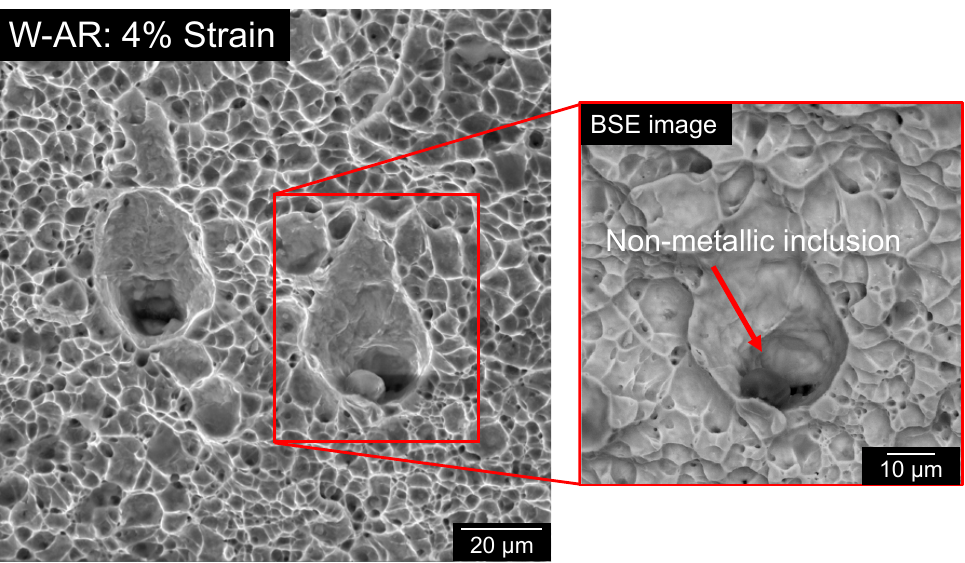
Figure 8. Non-metallic inclusion in W-AR sample. Right: Backscattered electron image of the inclusion.